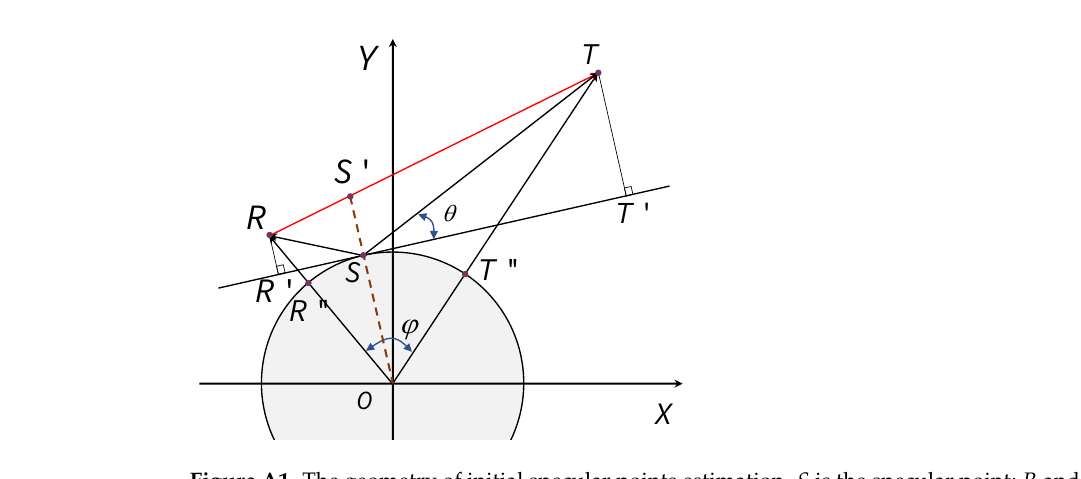
Figure A1. The geometry of initial specular points estimation. 𝑆 is the specular point; 𝑅 and 𝑇 denote the receiver and transmitter; 𝑅′ and 𝑇′ are the orthographic points on the tangent plane to the sphere Earth at 𝑆 ; 𝑆′ is the intersection of vector 𝑂𝑆⃗⃗⃗⃗⃗ and 𝑅𝑇 ⃗⃗⃗⃗⃗ .